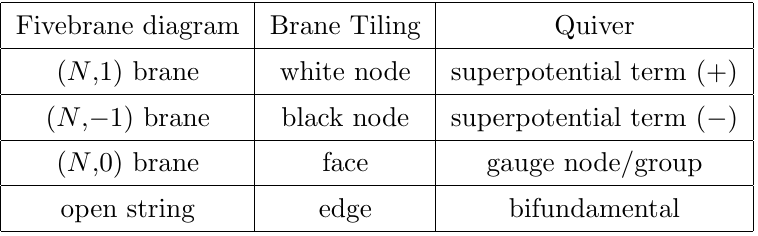
Table 2. The relation for (cid:12)vebrane diagrams, brane tilings and